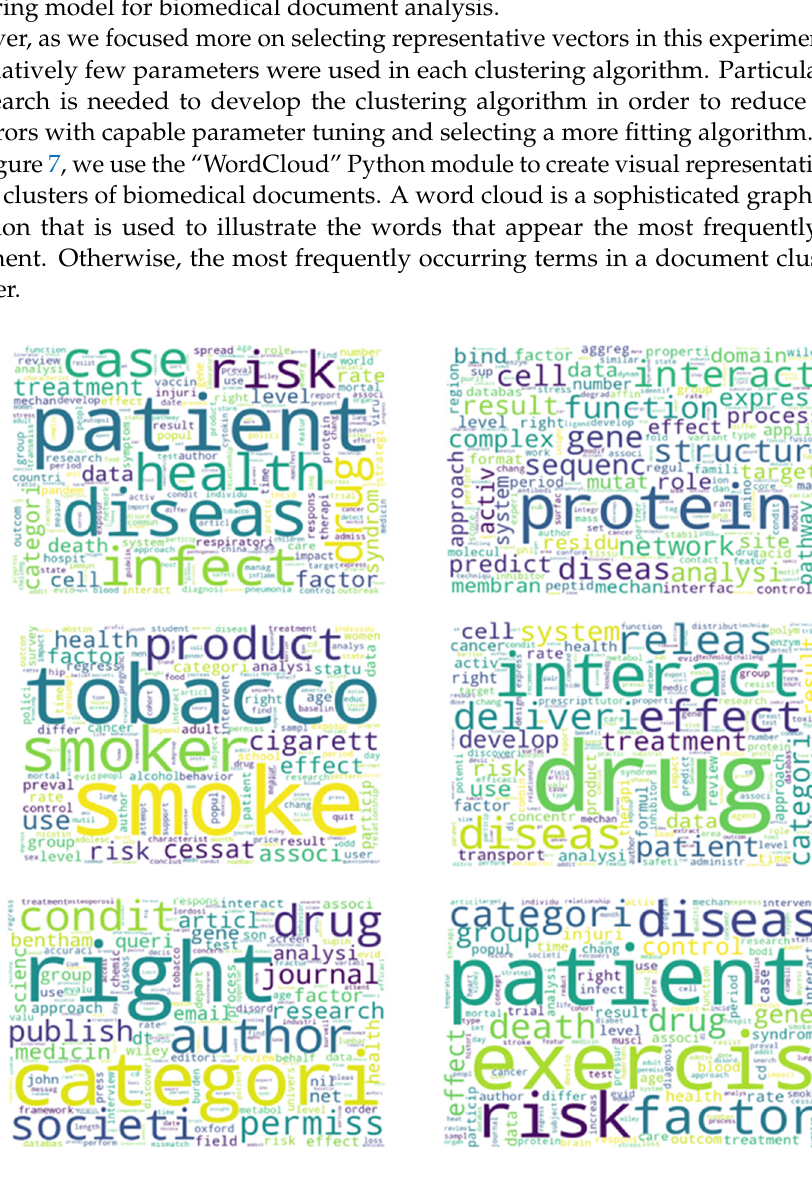
Figure 7. Word cloud representations for the biomedical documents clusters.